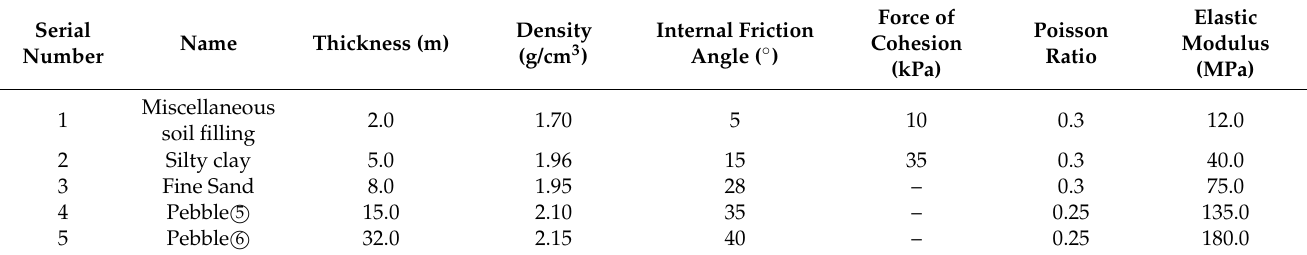
Table 5. Finite element model to simulate soil parameters .